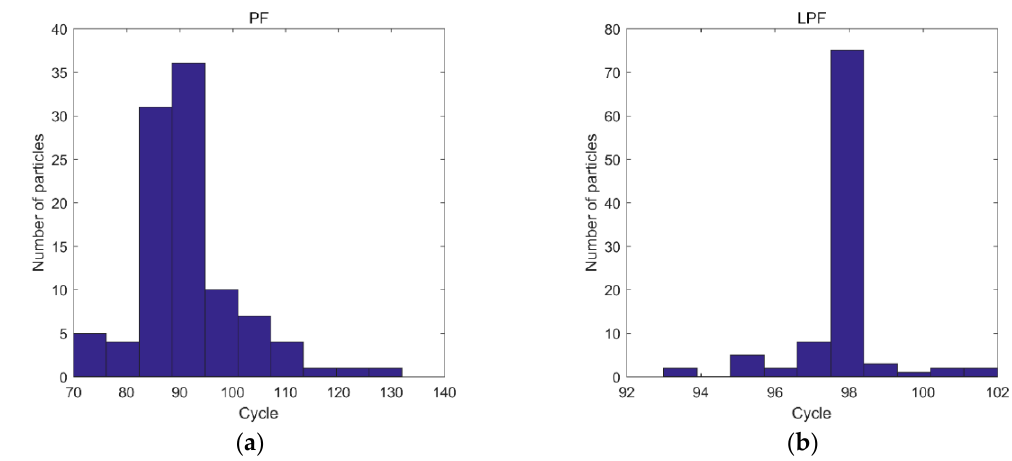
Figure 8. Prediction comparison using 70 cycles for battery B18 of a RUL of 97 cycles.